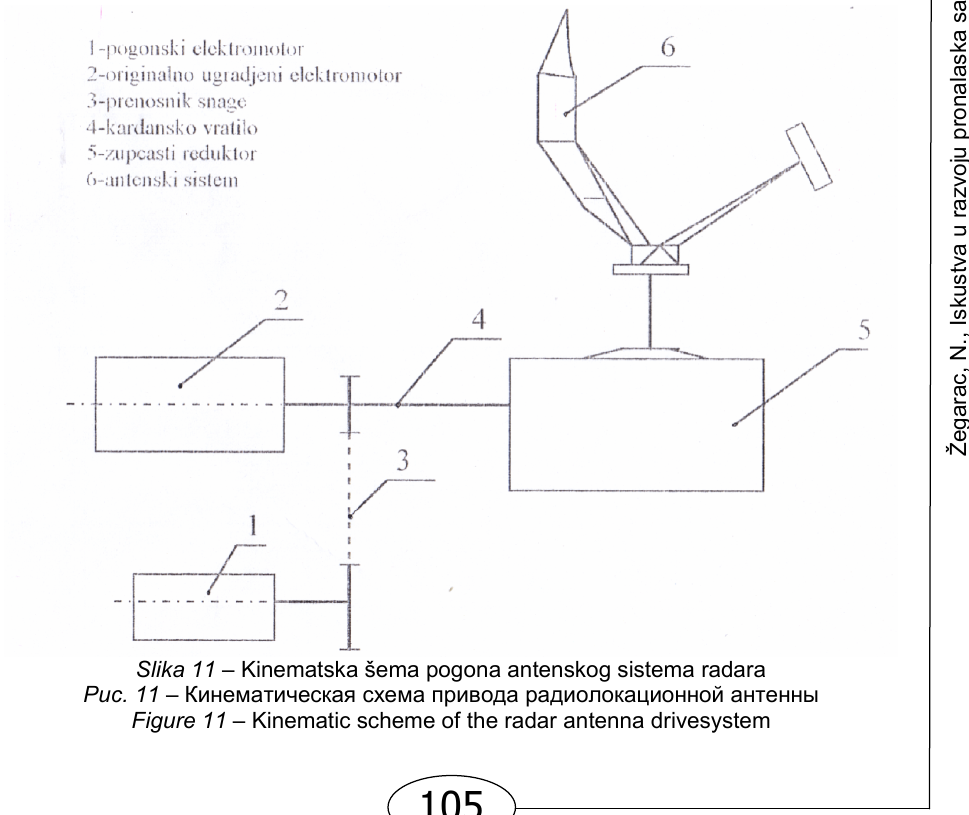
Рис . 11 – Кинематическая схема привода радиолокационной антенны Figure 11 – Kinematic scheme of the radar antenna